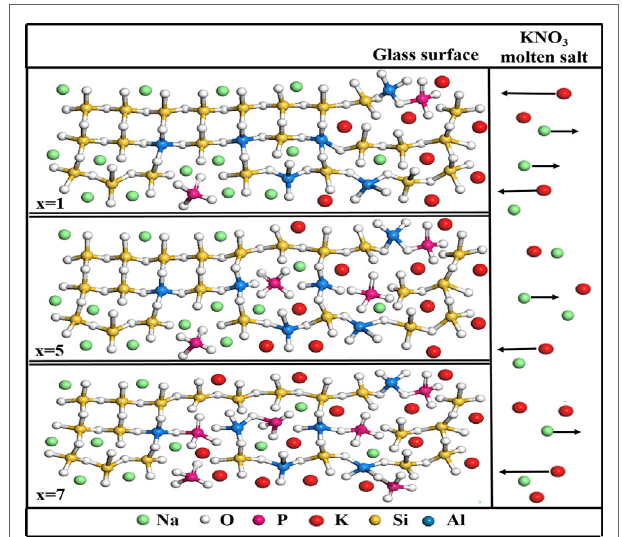
FigUre 6 | Micro-raman spectra of aluminosilicate glasses with x mol% P 2 O 5 concentration ( x = 1, 3, 5, 6, and 7 mol%, respectively) . FigUre 7 | schematic plot of ion-exchange process in the glass